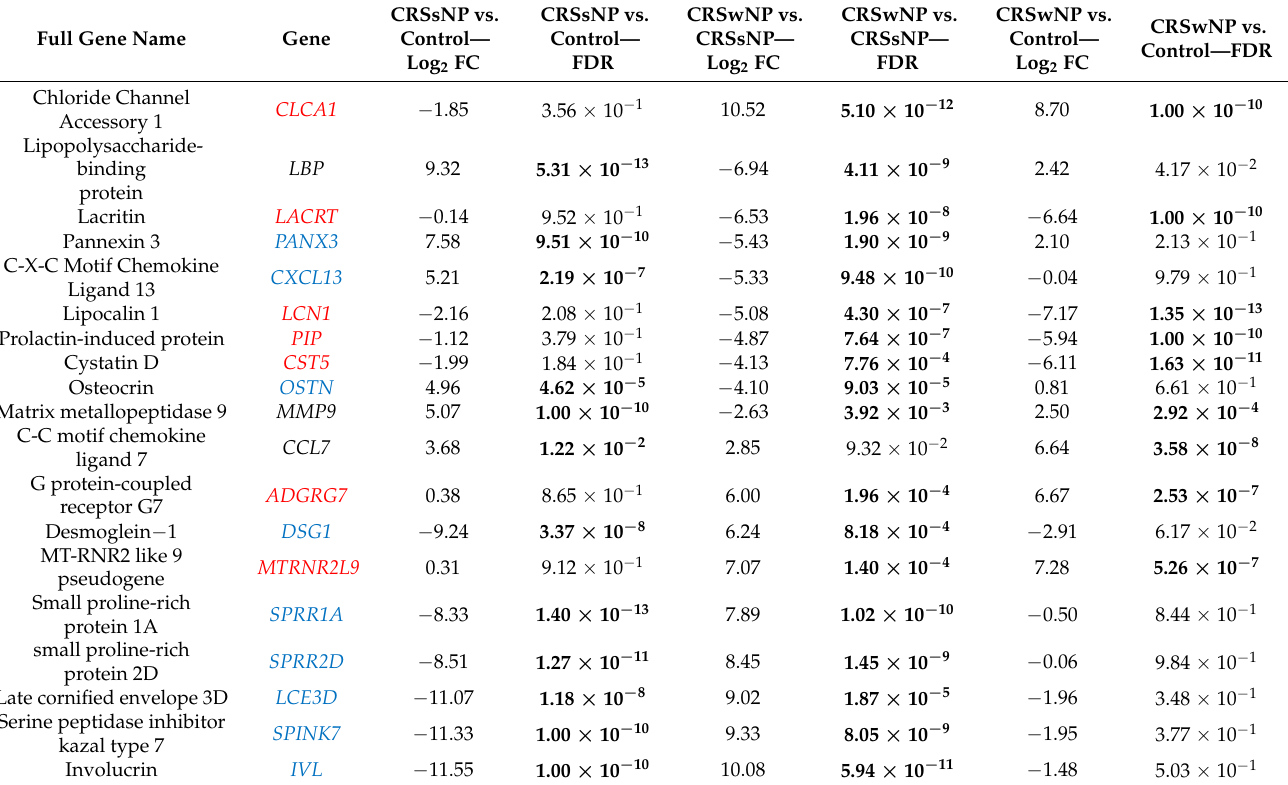
Table 2. Several unique phenotype genes are presented with their Log 2 fold change values and false discovery rate (FDR), comparing CRSwNP/CRSsNP and controls. FDR values of 0.05 or less are outlined in bold. Genes outlined in red ( • ) are CRSwNP-unique, and those outlined in blue ( • ) are CRSsNP-unique. The rest are differentially expressed in both CRS phenotypes (CRSwNP and CRSsNP).